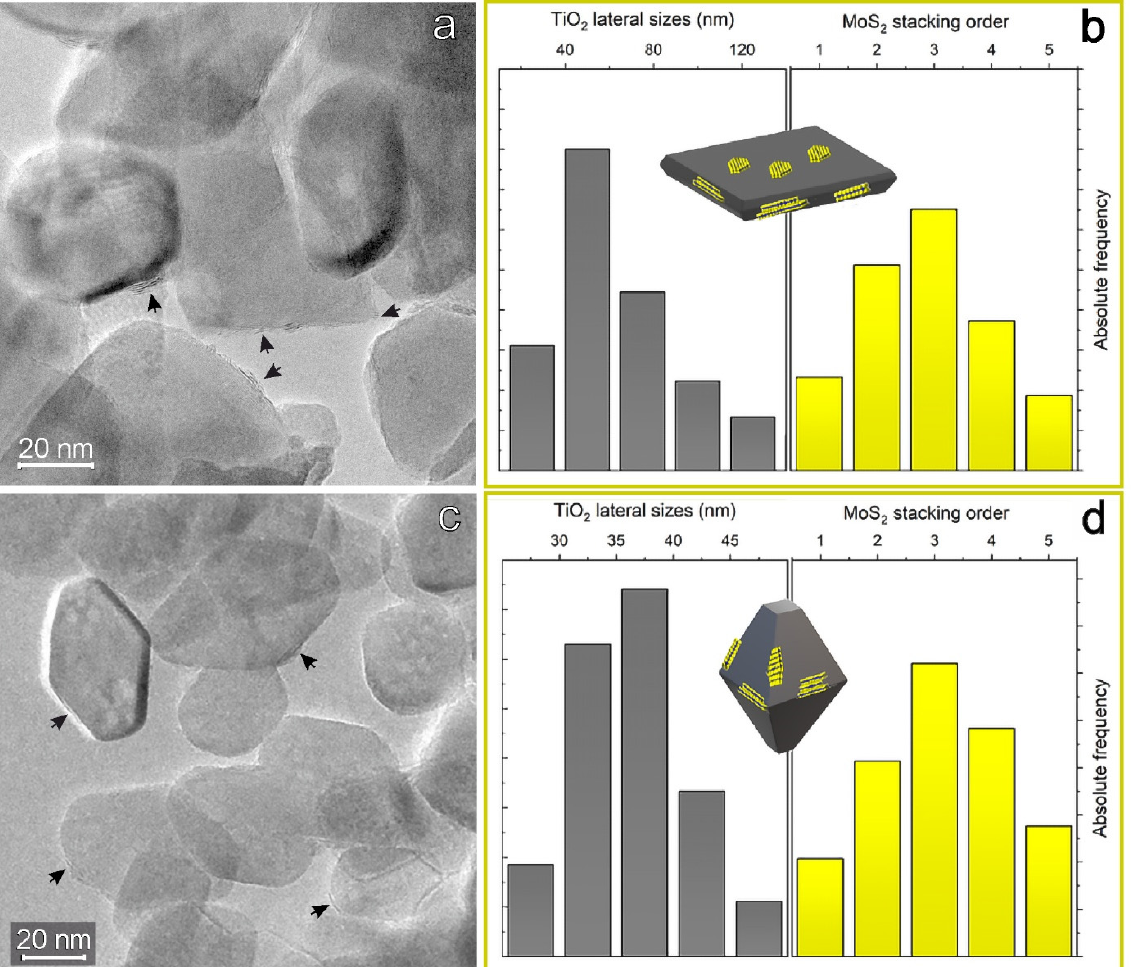
Figure 2. TEM images of: ( a ) MoS 2 /TiO 2 n-sh and ( c ) MoS 2 /TiO 2 bipy nanoparticles; lateral size dis- tribution of TiO 2 nanoparticles (grey histograms) and MoS 2 stacking order (yellow histograms) for: ( b ) MoS 2 /TiO 2 n-sh and ( d ) MoS 2 /TiO 2 bipy nanoparticles.